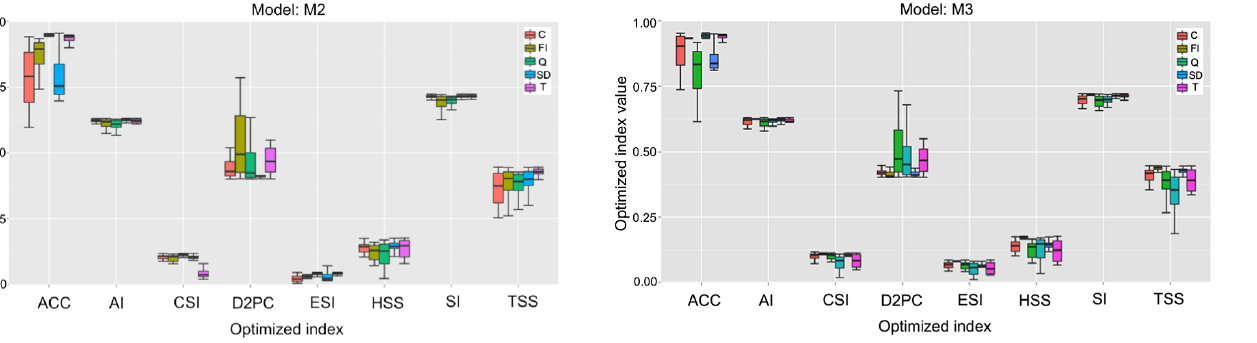
Figure 5. Model M2 parameters sensitivity analysis. Figure 6. Model M3 parameters sensitivity